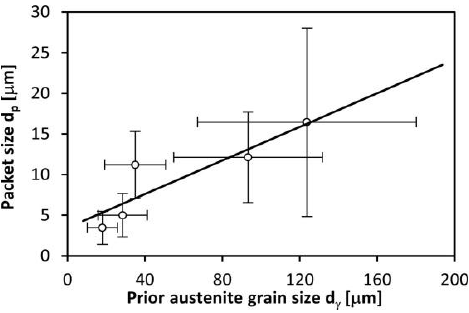
Figure 9. Relationship between the packet size and the prior austenite grain size in the Hardox 450